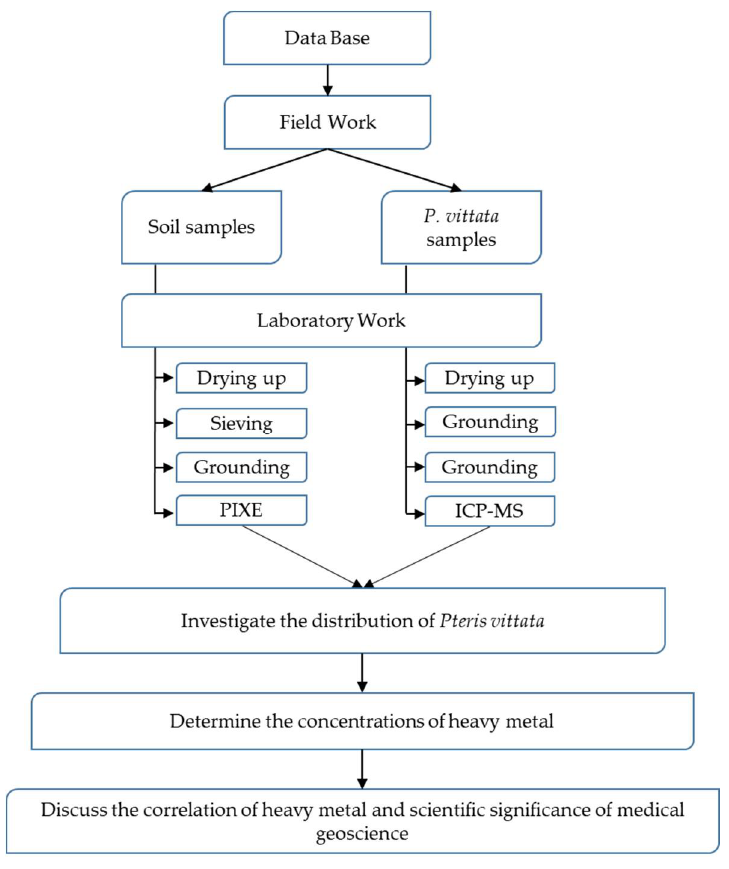
Figure 2. Flowchart of methodology.